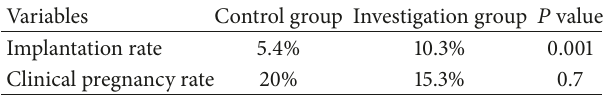
Table 3: Comparing mean outcomes of the studied groups.